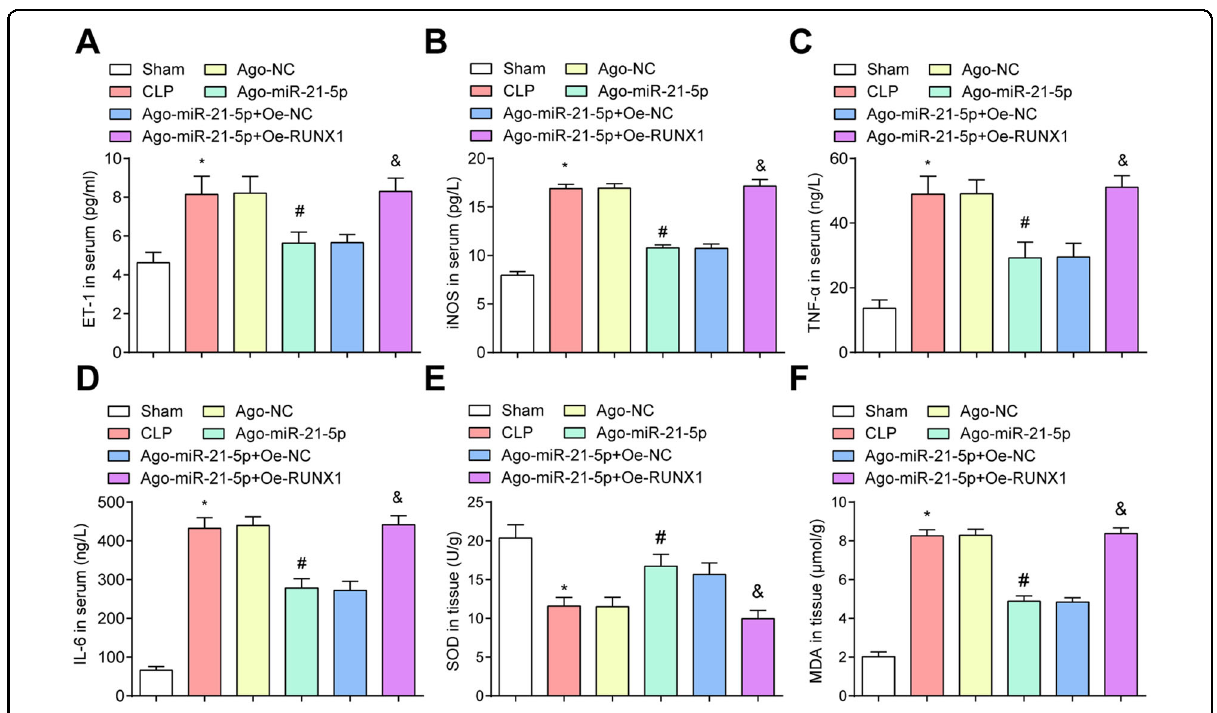
Fig. 3 Restored miR-21-5p attenuates the levels of serum-related indices and oxidative stress response in CLP rats. A Comparison of serum ET-1 levels in CLP rats. B Comparison of serum iNOS levels in CLP rats. C Comparison of serum TNF- α levels in CLP rats. D Comparison of serum IL-6 levels in rats. E Comparison of SOD activity in CLP rats. F Comparison of tissue MDA levels in CLP rats. n = 10. * P < 0.05 vs. the sham group. # P < 0.05 vs. the Ago-NC group. & P < 0.05 vs. the Ago-miR-21-5p + Oe-NC group. Measurement data were depicted as mean ± standard